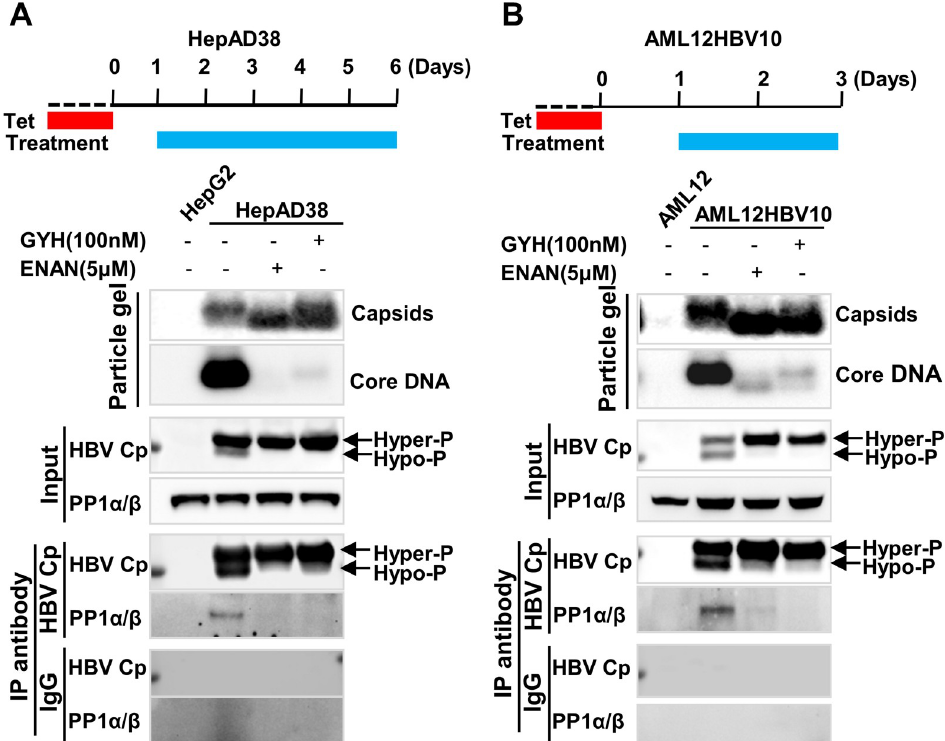
Fig 7. CpAMs inhibited PP1 α / β encapsidated in human and mouse hepatocytes. HepAD38 cell ( A ) and AML12HBV10 cell ( B ) were cultured in the absence of tet and mock-treated or treated with the indicated concentration GYH-2-18 (GYH) and ENAN-34017 (ENAN), starting at 24 h of tet removal, for 5 and 2 days, respectively (illustrated at upper panels). Parental HepG2 and AML12 cells were used as negative controls. Intracellular capsids and HBV DNA were determined by particle gel assay. The encapsidated PP1 α / β were detected by IP and Western blot assays. IP were performed with an antibody against HBV Cp or control IgG. HBV Cp, PP1 α and β in input cell lysates and immunocomplexes of IP were detected by Western blot assays with the corresponding antibodies.